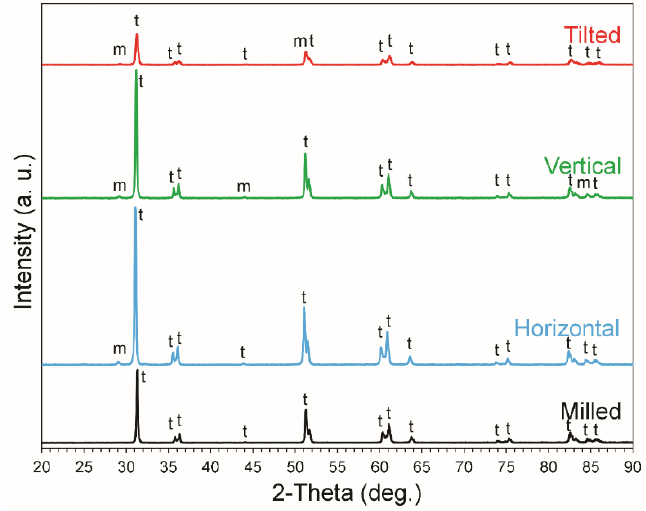
Figure 2. The XRD pattern of representative specimens from each group (m: monoclinic phase; t: tetragonal phase).